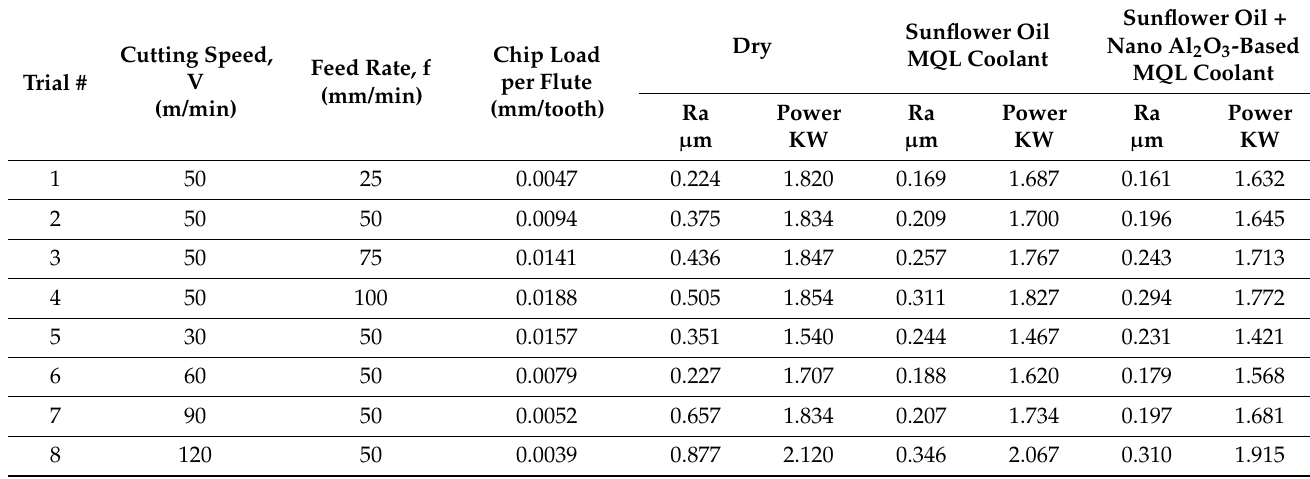
Table 4. Test runs under different cooling conditions; depth of cut = 0.75 mm, radial depth of cut = 4 mm.